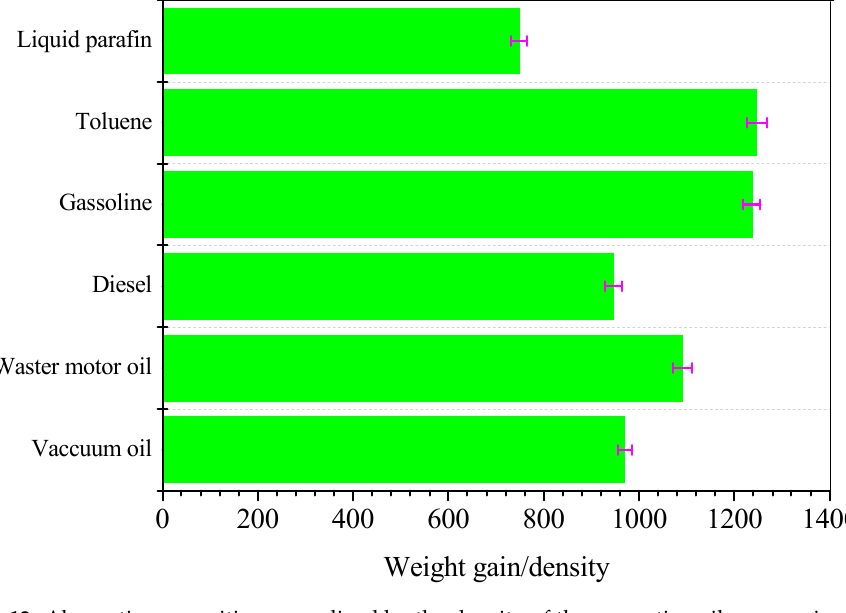
Figure 13. Absorption capacities normalized by the density of the respective oil or organic solvent.